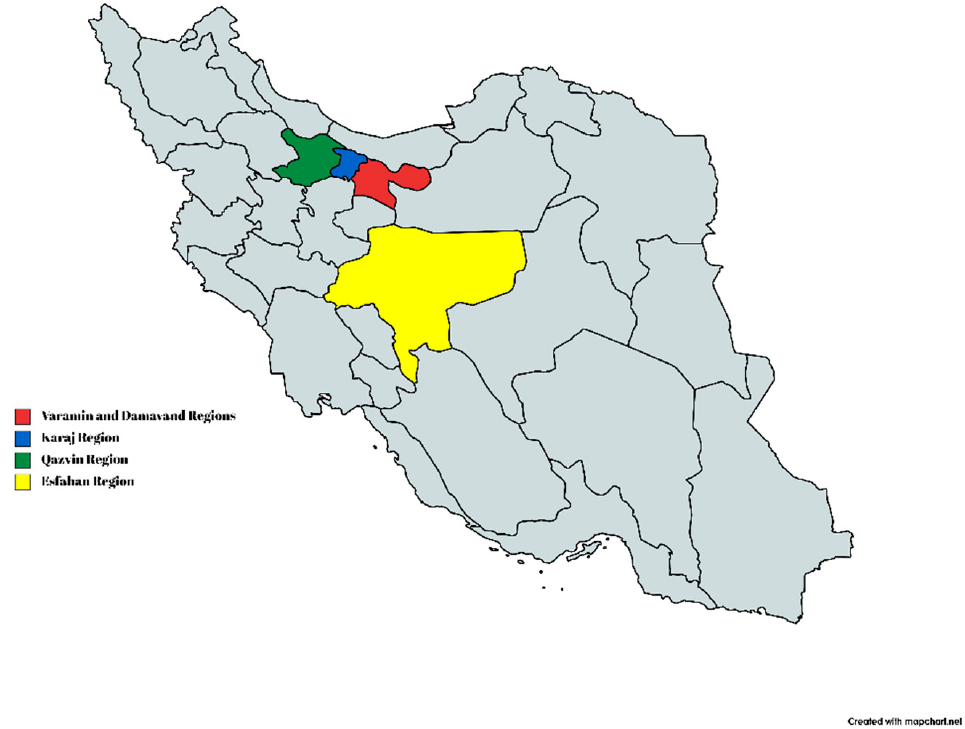
Figure 1. Experiment Locations in Iran